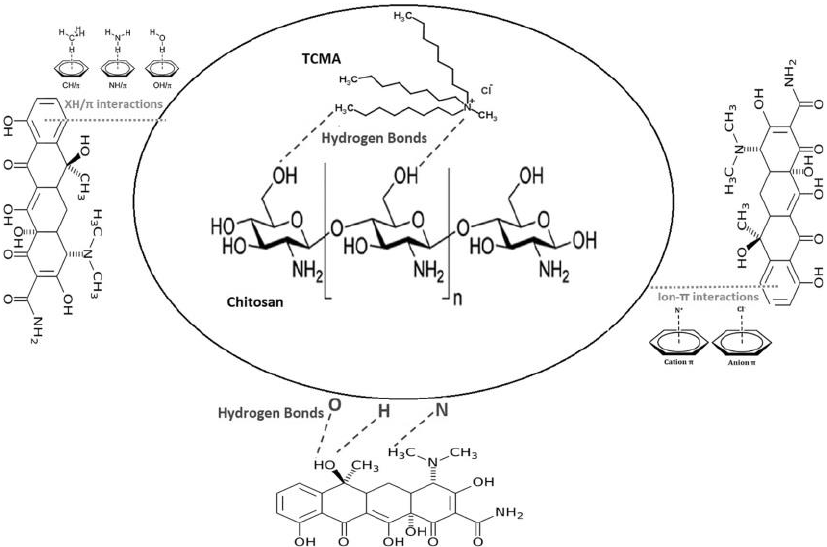
Figure 12. Schematic presenting of the structural reactions between TCMA and CS and then adsorbed molecule of TC on the surface of CS-TCMA [13].